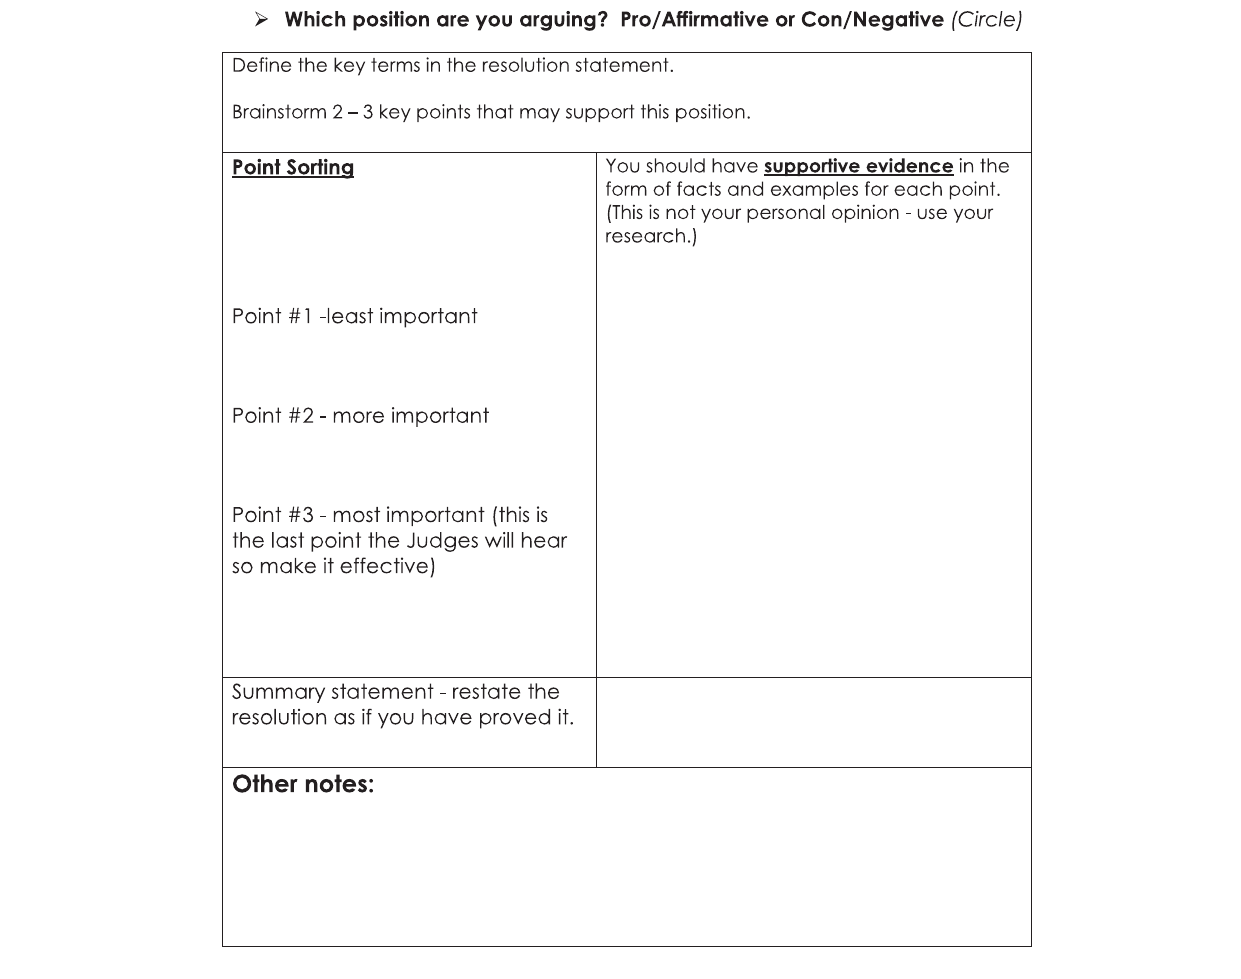
FIGURE 2 | Debater Guided Notes